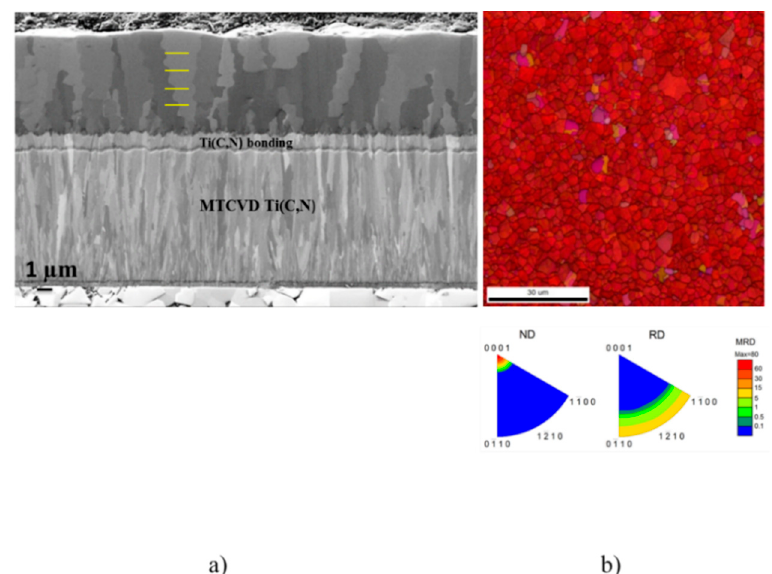
Figure 8. ( a ) Cross-section SEM micrograph of α -Al 2 O 3 coating (Coating g) deposited by alternating the (0001) and (1120) process conditions. The formation of zigzag grain boundaries in the coating can clearly be seen. Some (0001)-(1120) coating sequences are indicated on the micrograph. ( b ) EBSD IPF surface map of the α -Al 2 O 3 coating.